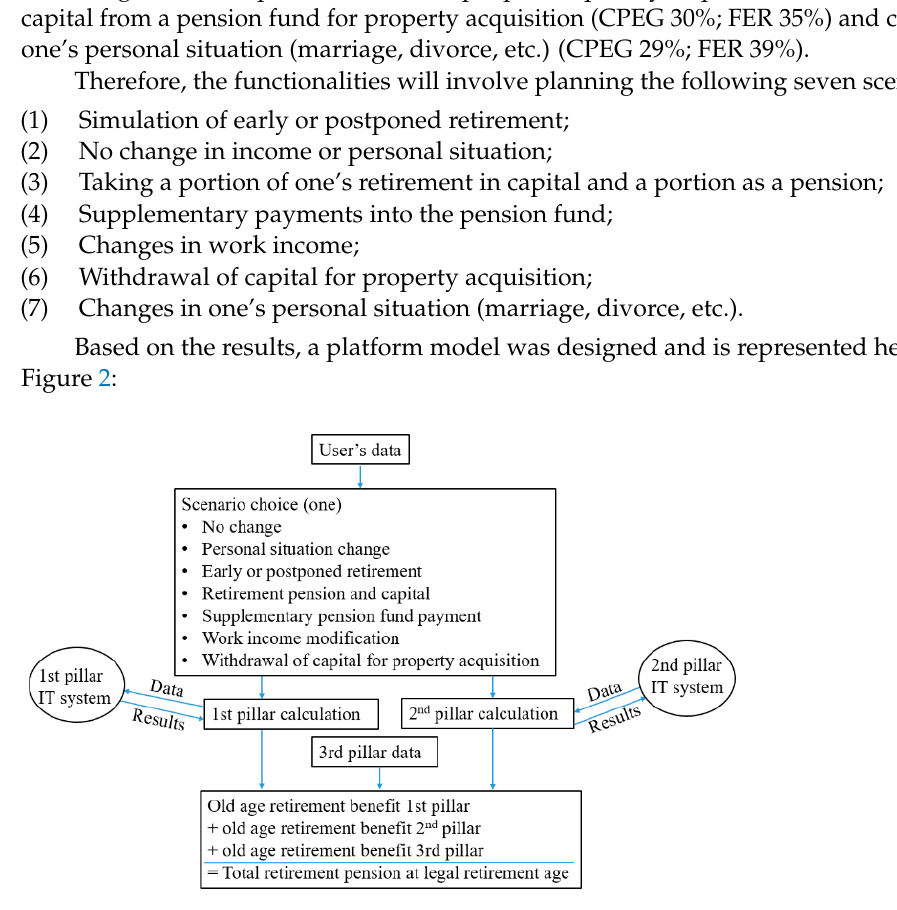
Figure 2. DIBS platform model.